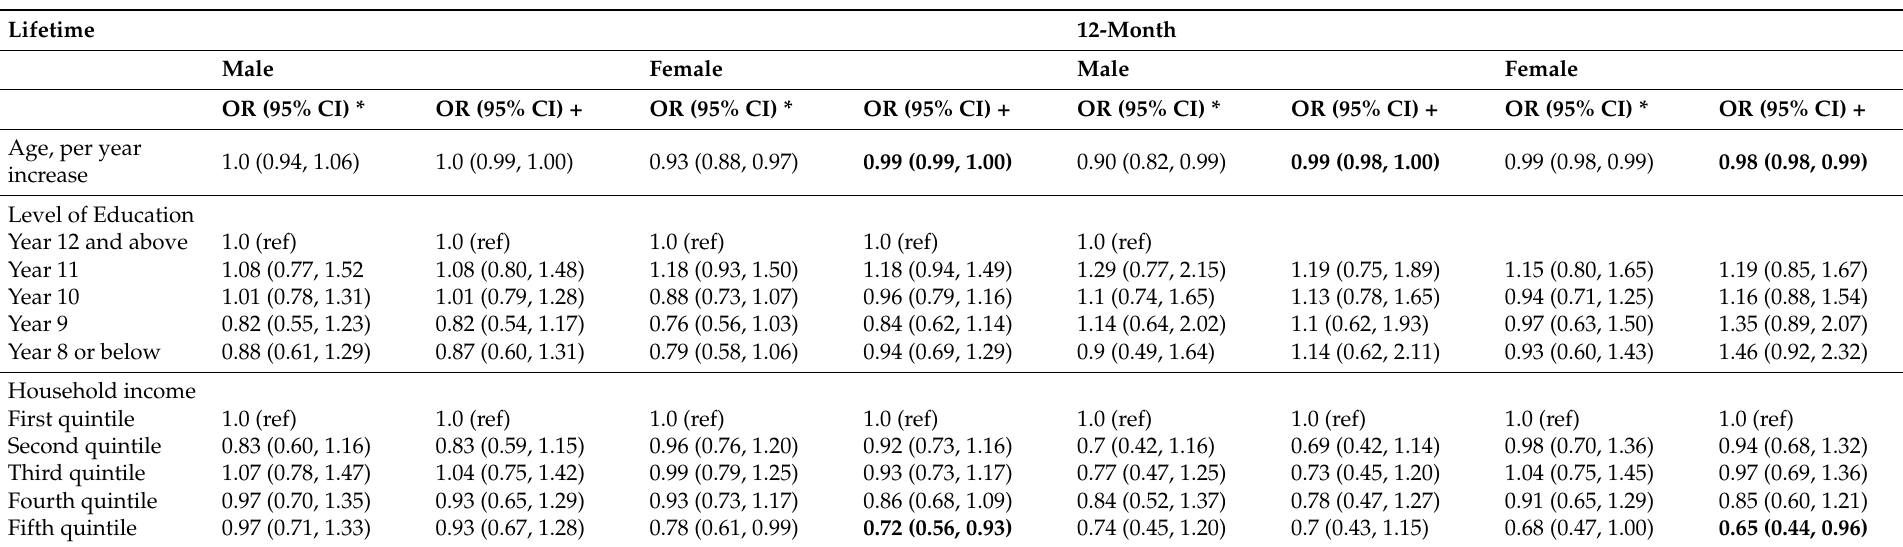
Table 3. Association of sociodemographic factors with lifetime and 12-month depression in total participants and by Gender in the 2007